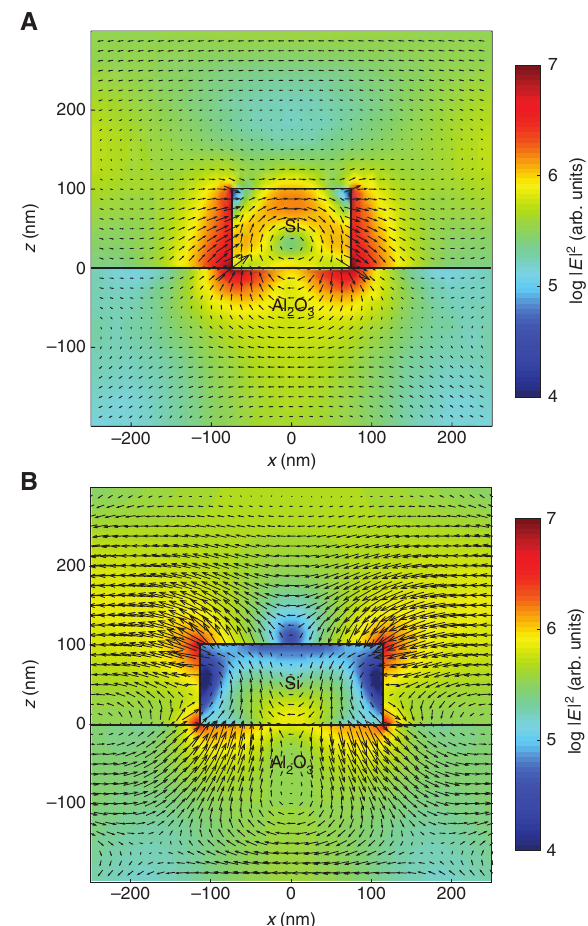
Figure 5: Magnetic and electric dipole near-field profiles. Logarithm of total electric field intensity (color scale) and orientation of the real in-plane part of the electric field (arrows) at resonance and under normal incidence, calculated for silicon nanodisks with (A) 150 nm and (B) 230 nm diameter. Here z < 0 represents the sapphire substrate. The smaller disk clearly exhibits a magnetic-dipole-like behavior, with a loop in the electric field amplitude inside the particle, while the larger disk shows an electric dipole behavior, with an antinode at the nanodisk